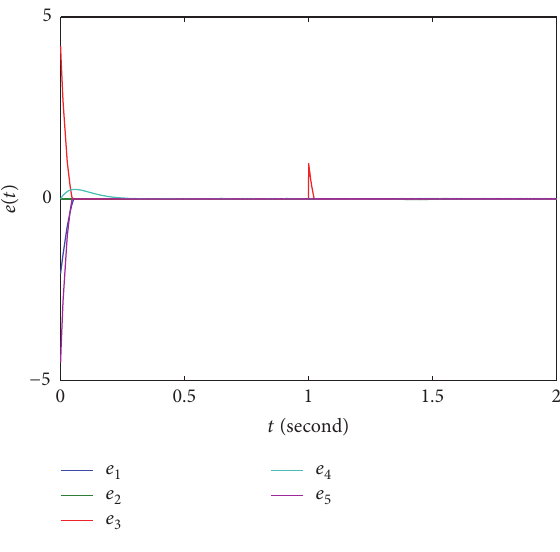
Figure 6: Time response of MFPLS error 𝑒 𝑖 (𝑡)